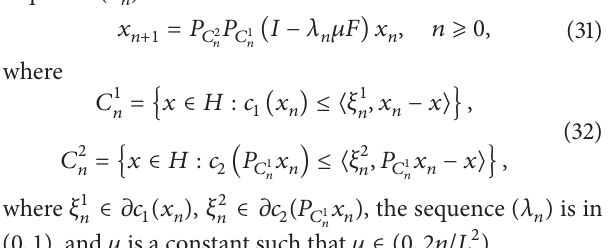
Algorithm 1. Choose an arbitrary initial guess 𝑥 0 ∈ 𝐻 . The sequence (𝑥 𝑛 ) is constructed via the